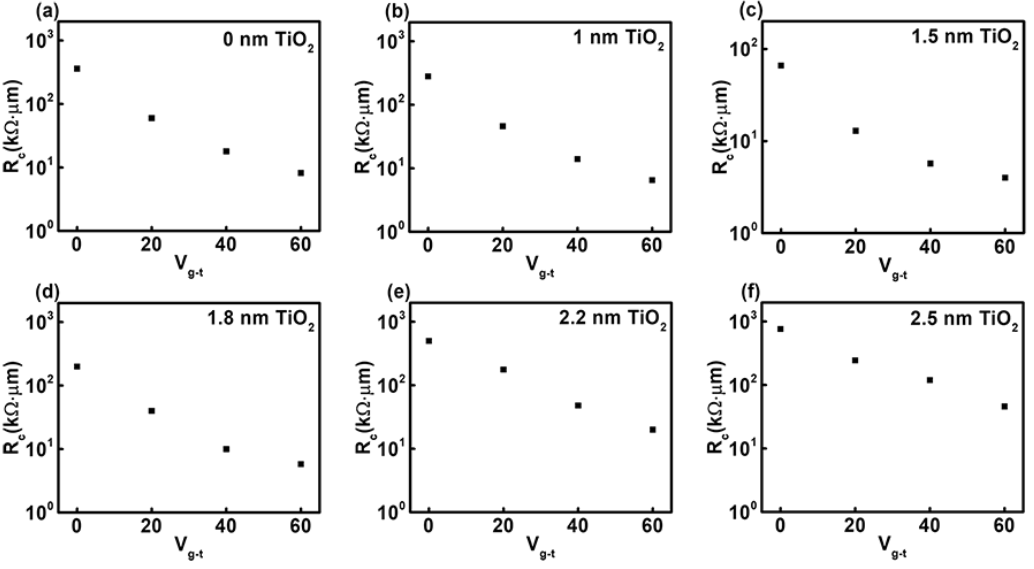
Figure 4. ( a – f ) Contact resistances for various TiO 2 thicknesses.